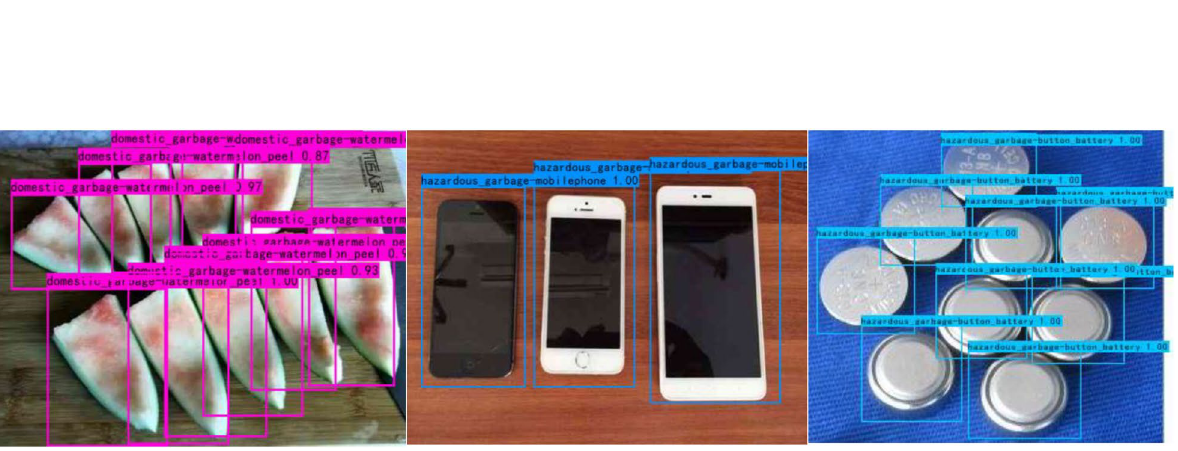
Figure 15. Images from the test dataset show the results of garbage